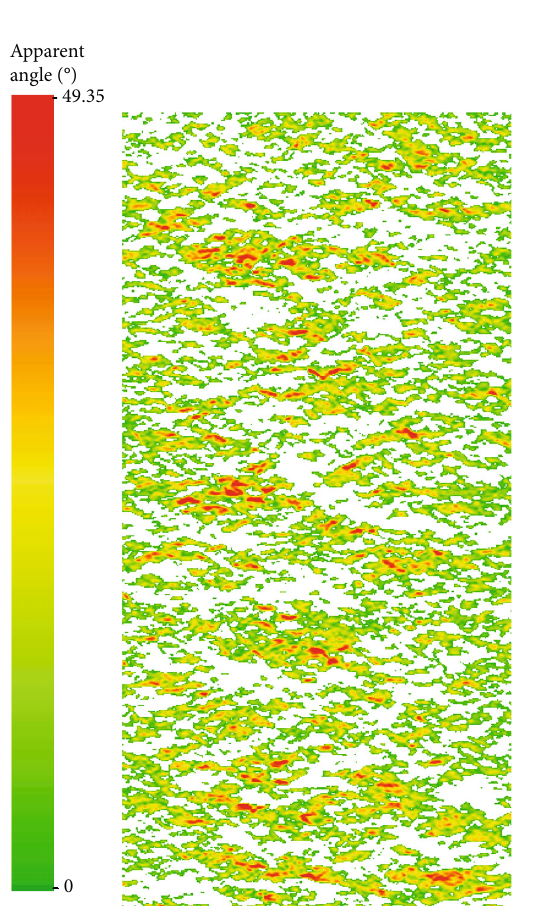
Figure 20: Distribution of apparent dip angle of joint